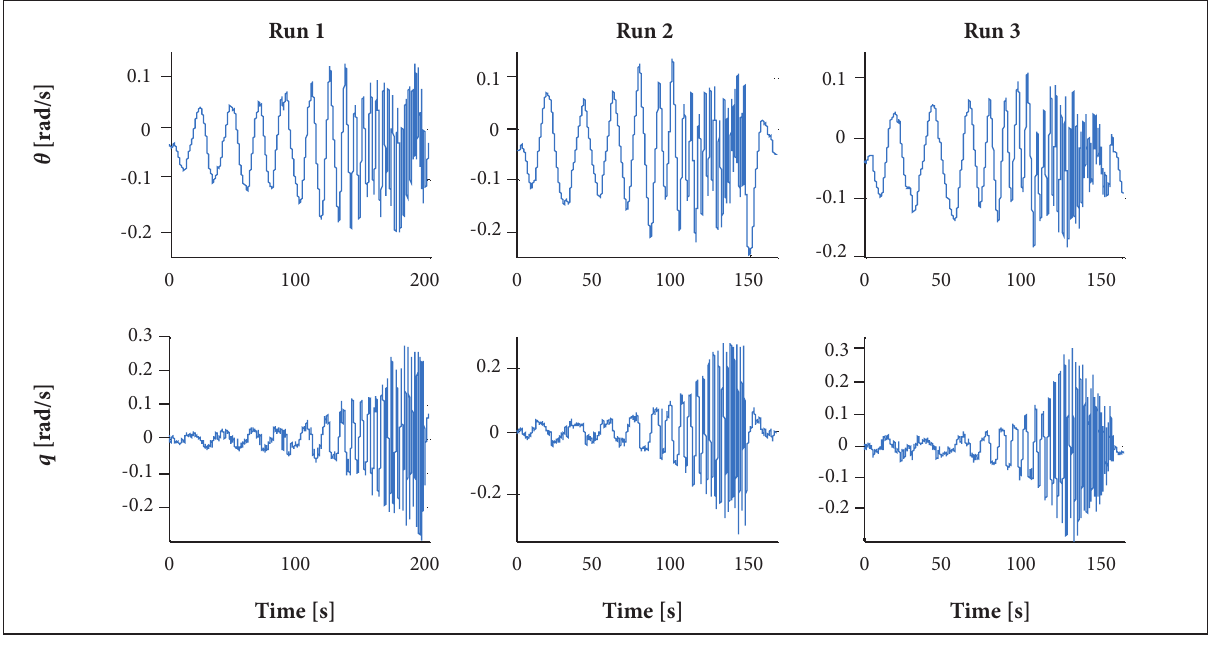
Figure 5. Longitudinal cyclic control input response — level flight (80 KIAS).